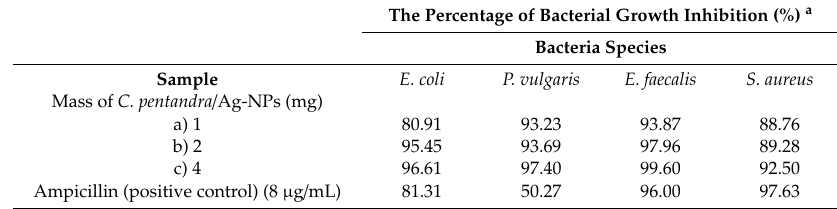
Table 3. The percentage of bacterial growth inhibition of C. pentandra / Ag-NPs against di ff erent bacteria